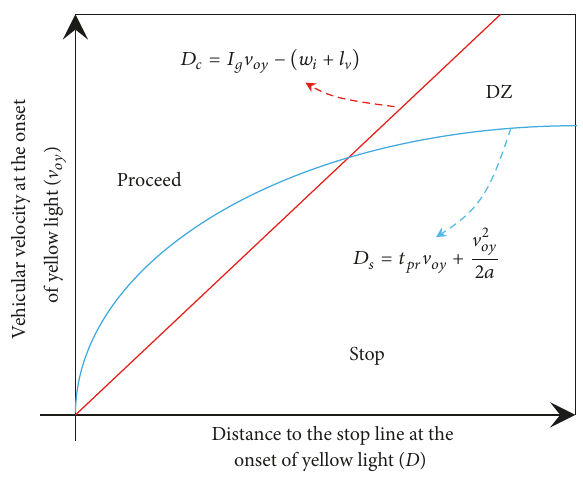
Figure 1: Relationship between vehicular velocity and distance to the stop line at the onset of yellow light and DZ.